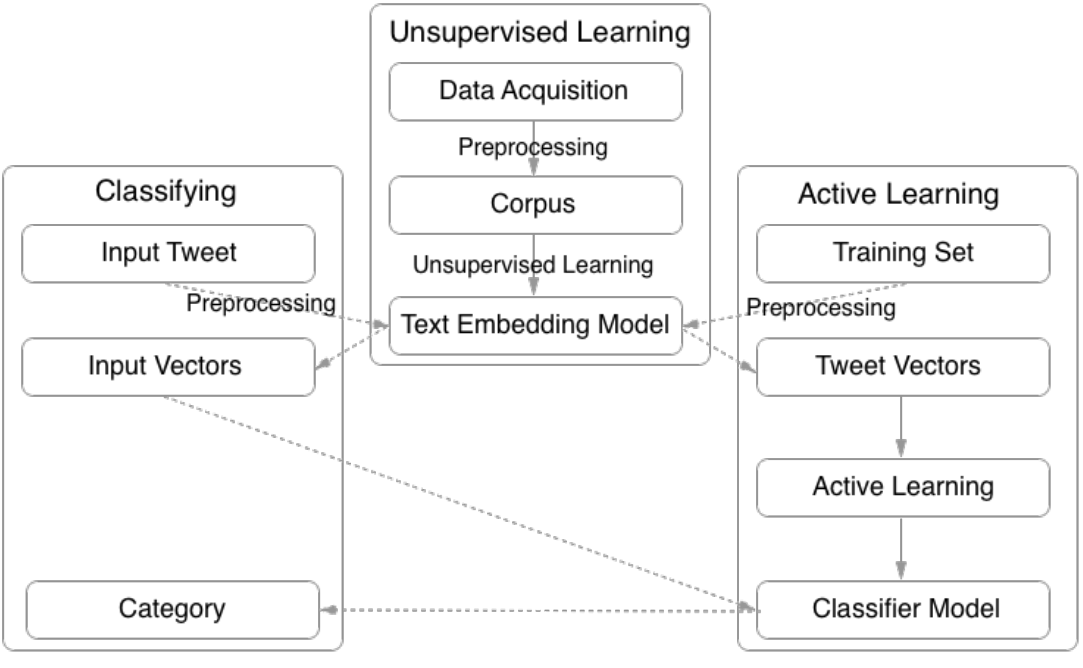
Figure 1. A workflow-level illustration of the data acquisition, filtering and labeling pipeline. The ‘Input Vectors’ are also used in a system called HashViz to visually explore the data, as subsequently